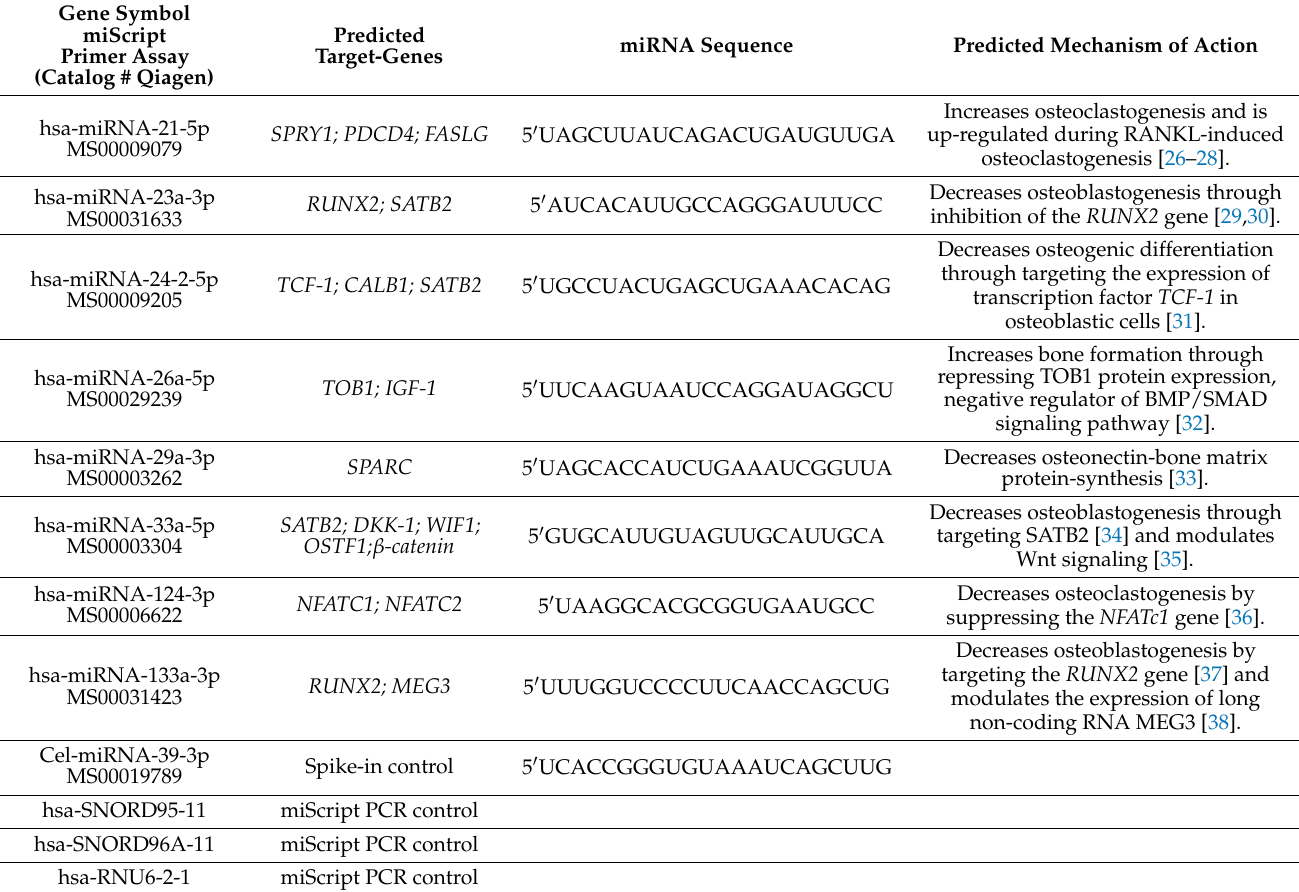
Table 1. Pre-specified panel of selected miRNAs linked to bone